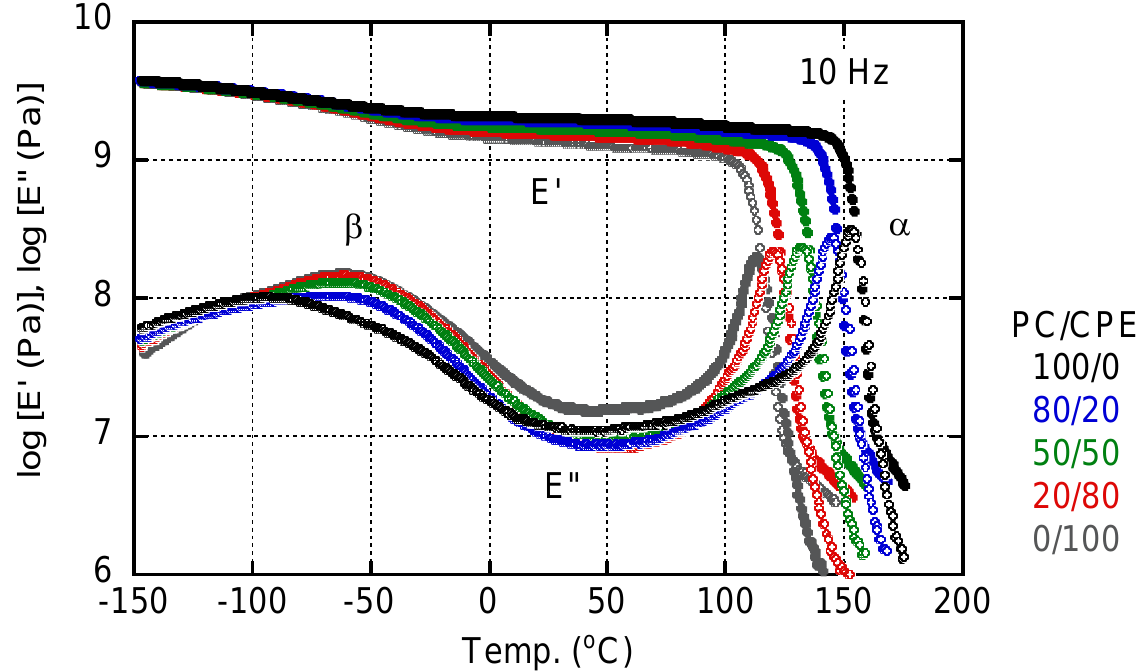
Figure 4. Temperature dependence of tensile storage moduli E ′ and loss modulus E ″ at 10 Hz.